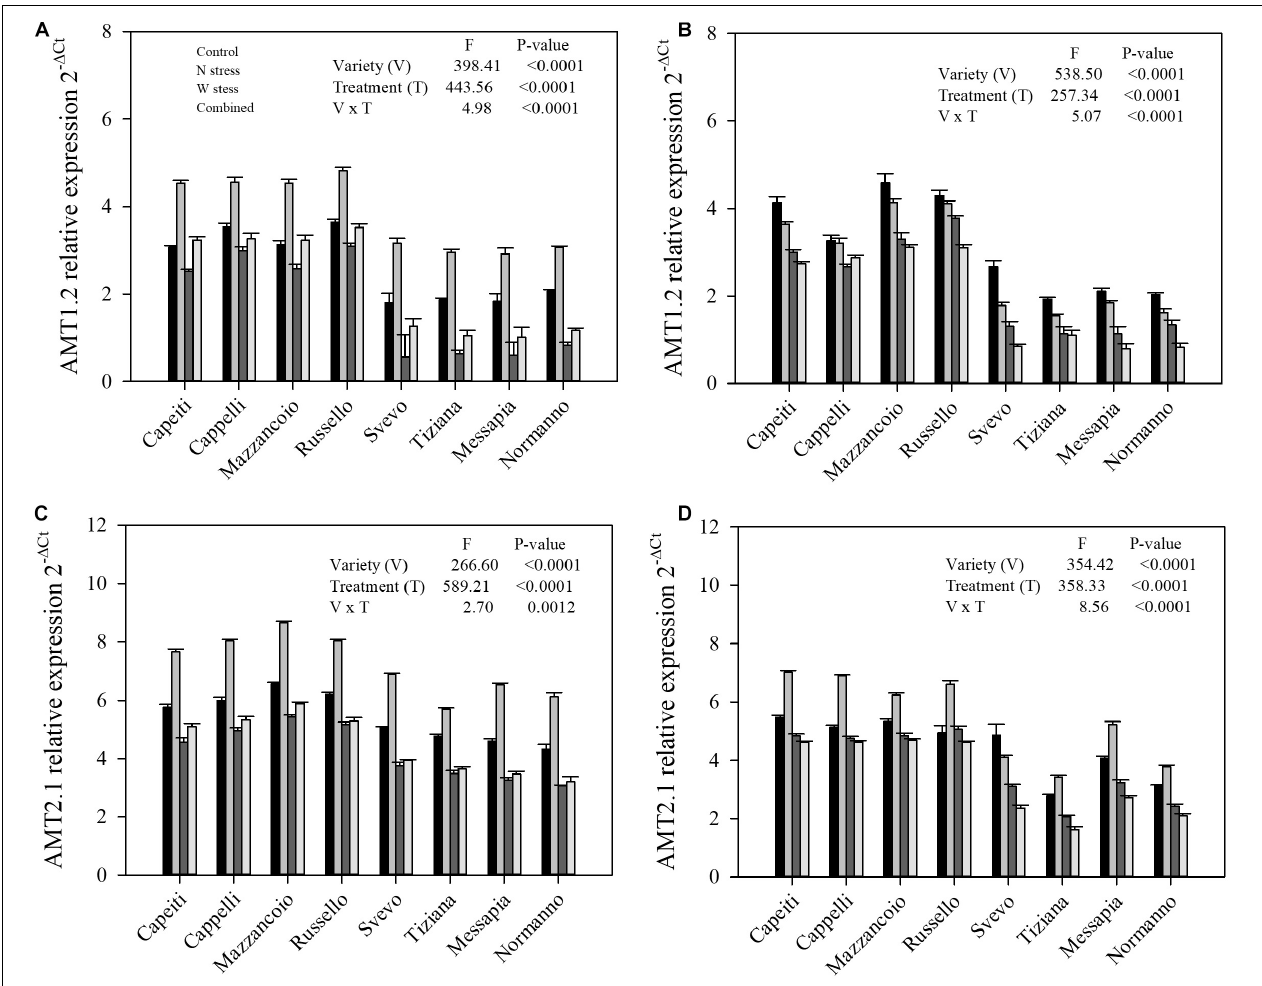
FIGURE 9 | Expression of gene relative to ammonium transporter in durum wheat root. AMT1.2 relative expression at stem elongation (A) and milk ripening (B) are shown; AMT2.1 relative expression at stem elongation (C) and milk ripening (D) are